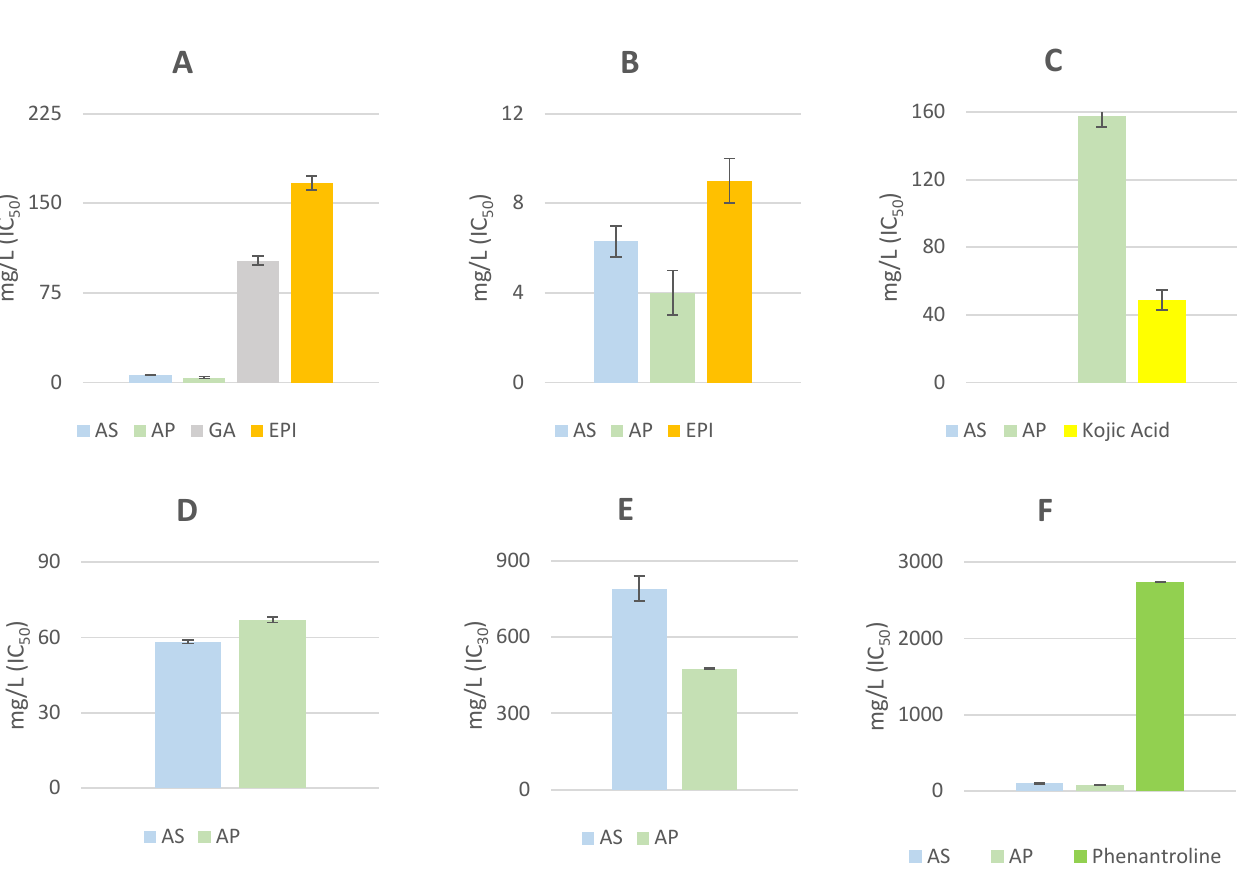
Figure 2. Radical scavenging assessment of ( A )·O 2 , ( B )·NO and ( C ) HOCl by avocado seed (AS) and peel (AP). Results are expressed as the concentration in mg/L needed to inhibit the response by 50% (IC 50 ). Data are means ± standard deviation (n = 3) Positive controls used were GA, gallic acid, and EPI, epicatechin.